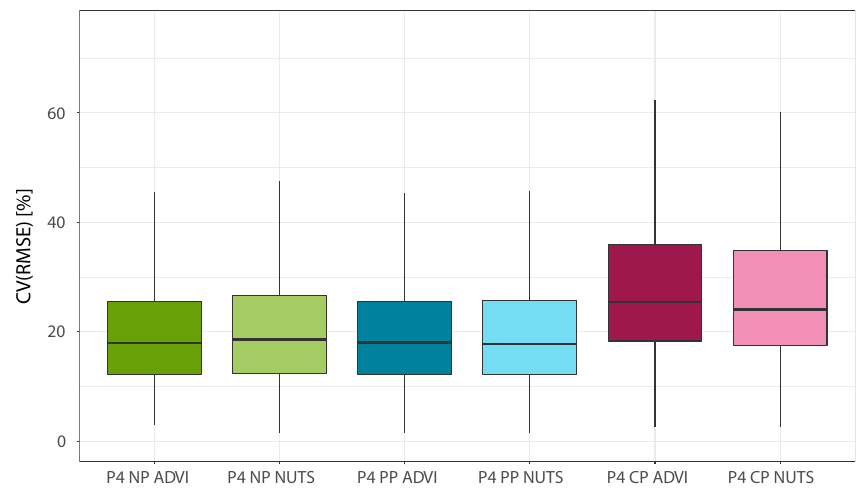
Figure 5. CV(RMSE) results obtained in Phase 4 of model comparison.